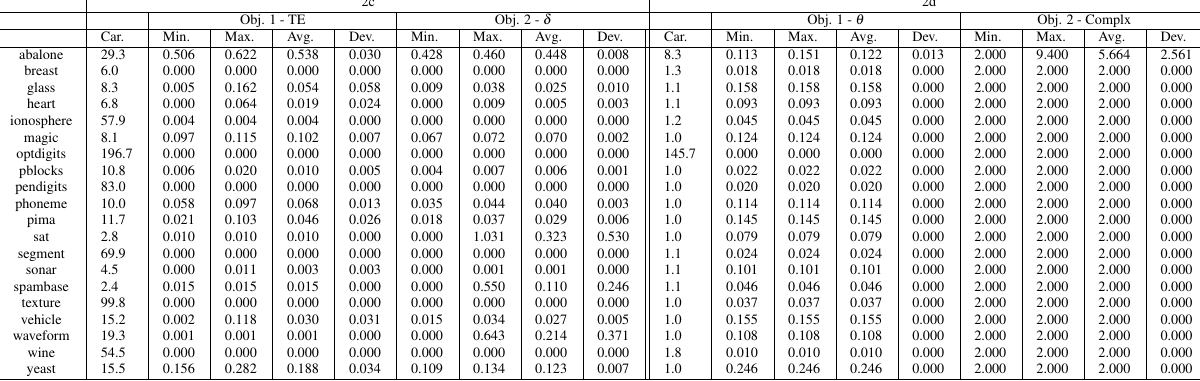
Table 4: Statistics of the Pareto front approximations with the original objectives. 2c 2d Obj. 1-TE Obj. 2-Complx Car.